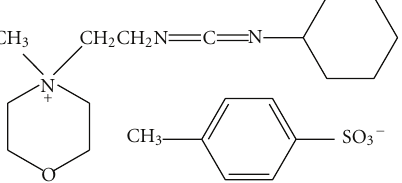
5 (cid:2) splice sites and the ( − ) oriented Alu has more 3 (cid:2) splice sites. It may suggest that exonization may occur from the 5 (cid:2) side of (+) Alu elements and 3 (cid:2) side of ( − ) Alu elements. The SRP RNA (7SL RNA) has Alu elements in its sequence [79]. Whether the Alu is derived from 7SL or Alu is exonized to 7SL is not clear. Subsequently, other snRNAs have been